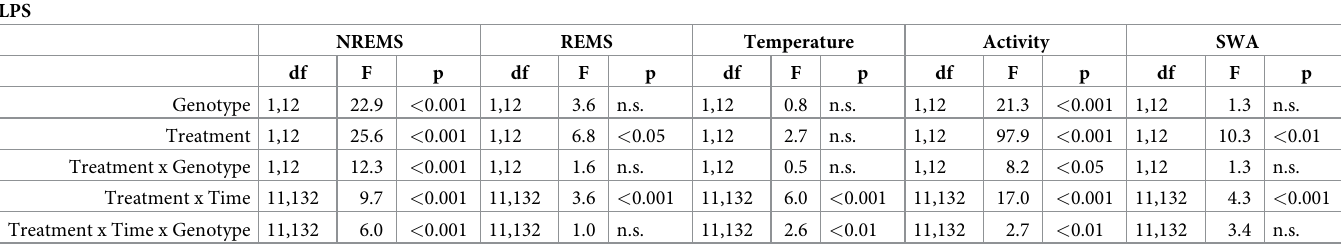
Table 4. Non-rapid-eye movement sleep (NREMS), rapid-eye movement sleep (REMS), body temperature, motor activity and electroencephalographic slow-wave activity (SWA) after LPS administration: Statistical results. LPS